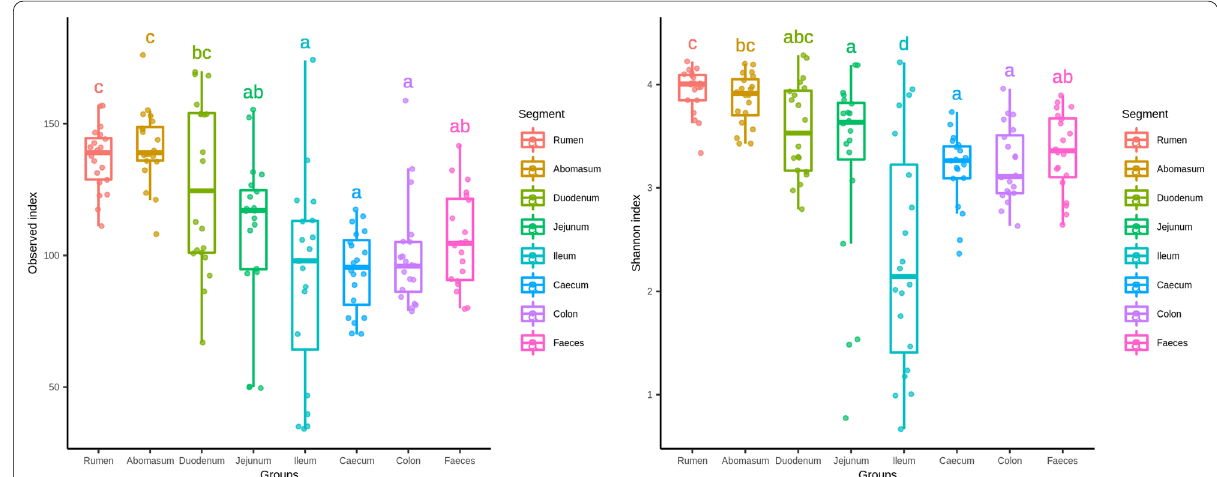
Fig. 1 Differences in alpha diversity values, tested by ANOVA, among gastro-intestinal tract (GIT) segments from High- and Low-FEC sheep. a,b,c Means followed by different letters above the graphs indicate statistically significant differences ( p < 0.05). Graphs that share the same letter do not differ significantly